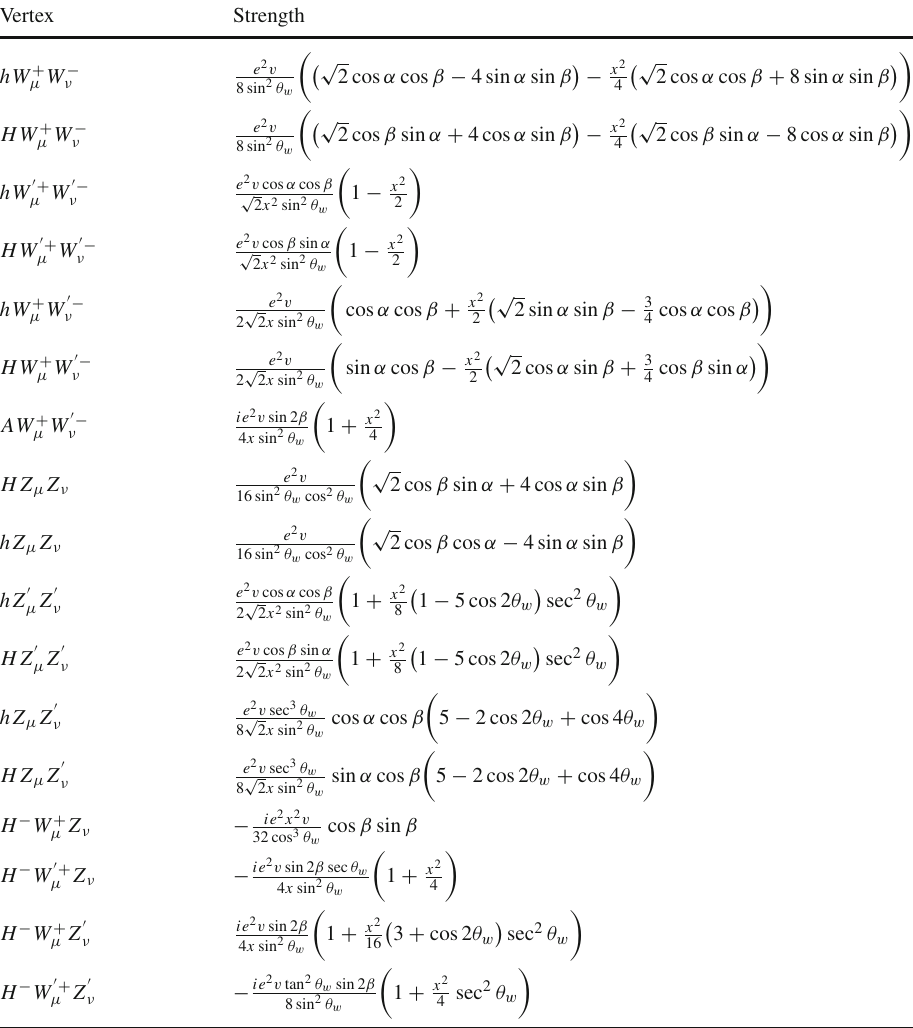
Table 2 All the triple point V V X couplings in the models where V is a (light or heavy) gauge boson and X is a scalar. These have been computed to O ( x 2